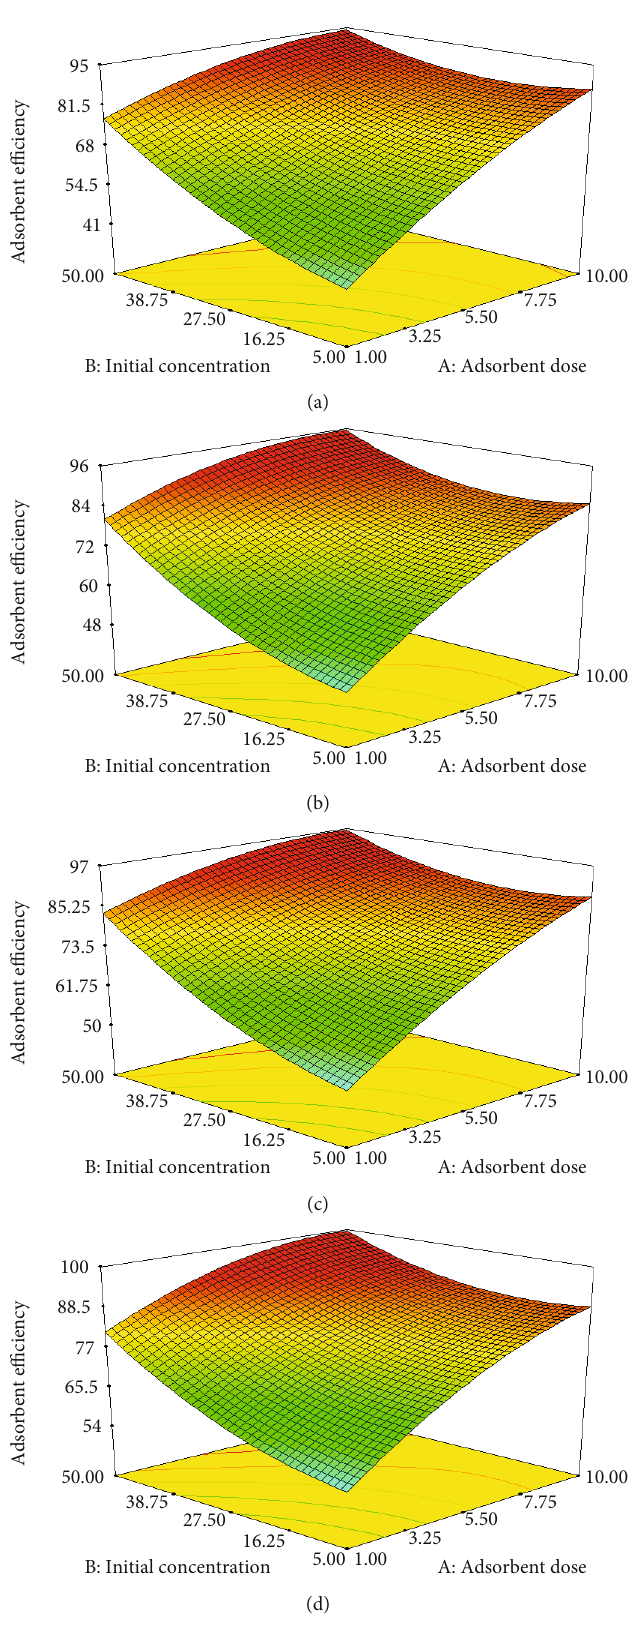
Figure 5: Mutual e ff ect of adsorbent dose and initial concentration on the adsorption e ffi ciency of TAADFPs activated at (a) 450 ° C, (b) 500 ° C, (c) 550 ° C, and (d) 600 °